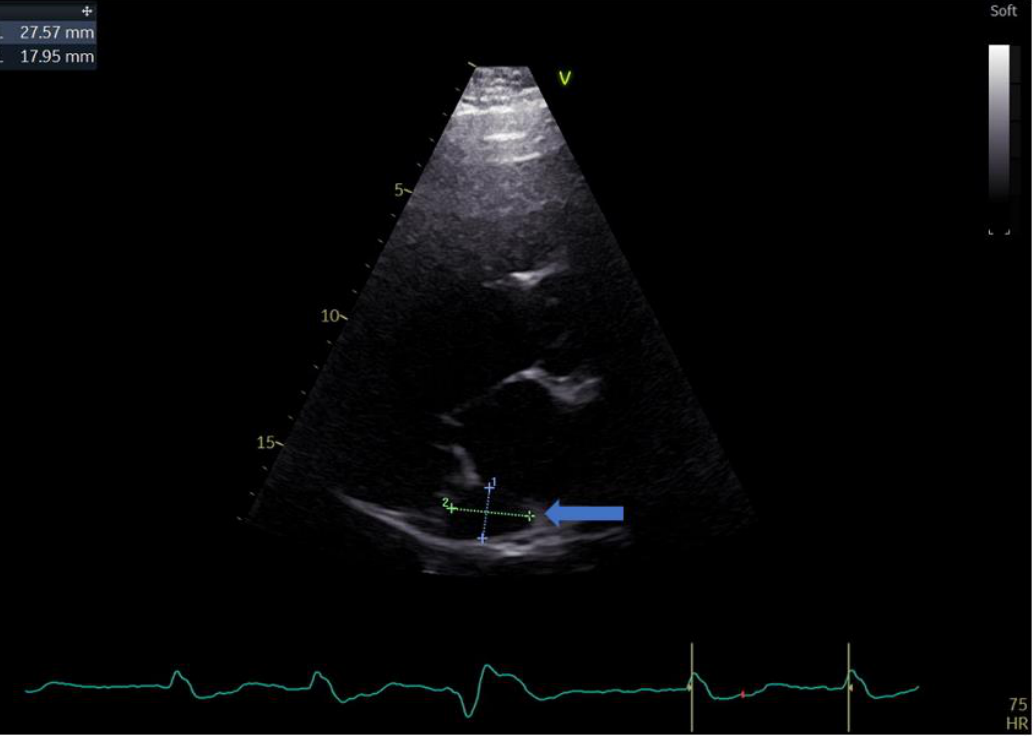
Figure 2. Parasternal long-axis view showing the measurements of the coronary sinus (blue arrow).